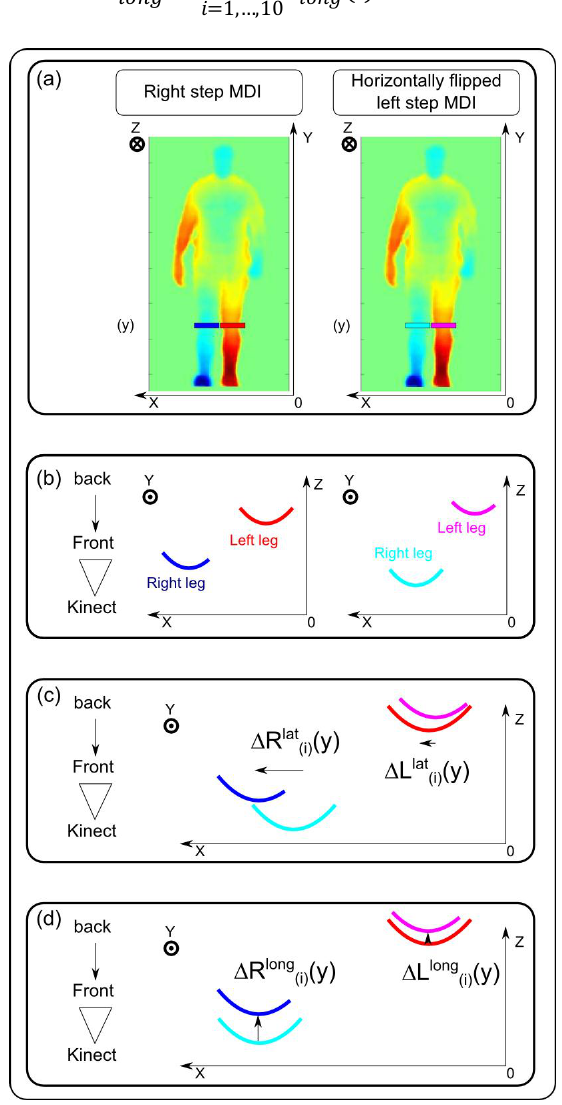
Figure 3. ( a ) Position of the horizontal lines (y) selected in the legs from right step MDI( i ) and corresponding left step fMDI( i ), for lateral and longitudinal asymmetry evaluation ; ( b ) representation of these horizontal lines in the transverse plane. Each leg depth curve is plotted in red and blue for, respectively, the right and left legs of the right step MDI( i ) and cyan and magenta for, respectively, the right and left legs of the left step fMDI( i ). ( c ) Lateral differences ∆𝑅 (𝑖)𝑙𝑎𝑡 (𝑦) and ∆𝐿 (𝑖)𝑙𝑎𝑡 (y) are calculated with a lateral inter-correlation of corresponding leg depth curves; ( d ) once the legs of the left step are laterally registered on the legs of the right step, the depth differences ∆𝑅 (𝑖)𝑙𝑜𝑛𝑔 (𝑦) and ∆𝐿 (𝑖)𝑙𝑜𝑛𝑔 (y) are computed by averaging the depth difference between depth